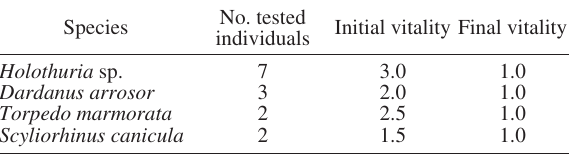
Table 2. – Delayed survival of some discarded species after seven days in captivity conditions. Mean values of the initial (Day 0) and